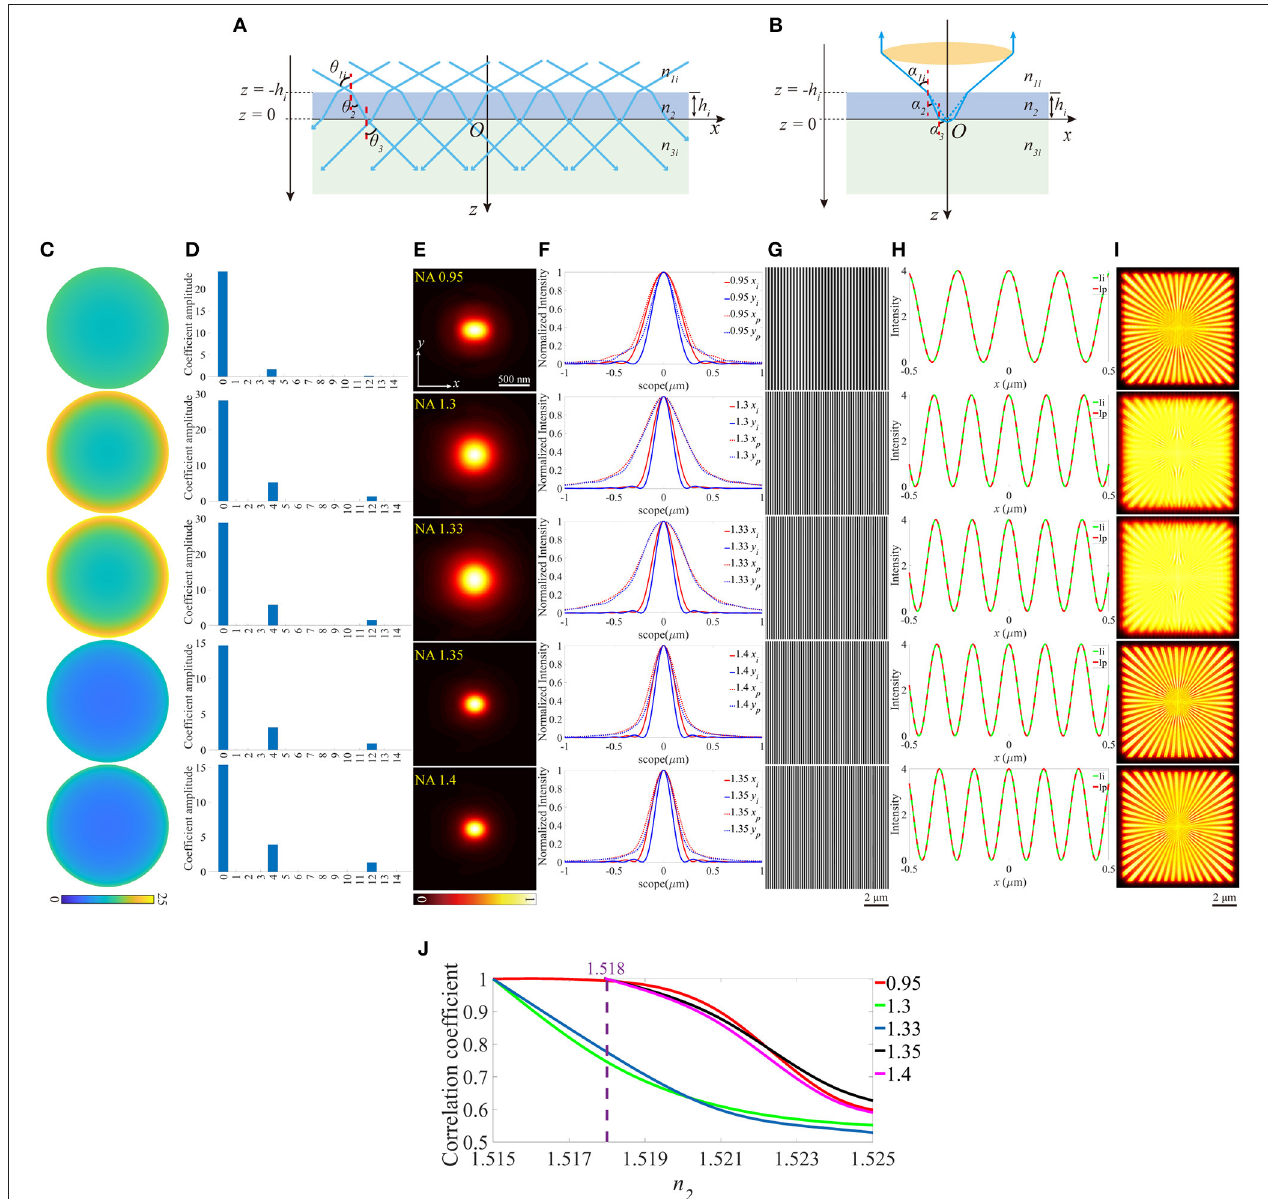
FIGURE 2 | The aberrations induced by the deviation of the RI of the coverslip. (A,B) The RIs between the immersion medium and the coverslip mismatch for the illumination path and the detection path, respectively. (C) The pupil functions calculated from the case depicted in (B) . (D) Zernike decomposition of the pupil functions shown in (C) . (E) The PSFs on the plane z = 0, calculated from the corresponding pupil functions. (F) The profiles of the ideal (solid line) and biased (dashed line) PSFs in (E) . (G) The excitation patterns affected by these biased RIs. (H) The local profiles of the corresponding excitation patterns shown in (G) . The red dashed line Ip presents the biased case and the green solid line Ii presents the ideal case, respectively. The scope is − 0.5 ∼ 0.5 µ m. (I) The corresponding reconstructed images of SIM. (J) The correlation coefficients of SIM images with different n 2 and NAs. The purple dashed line corresponds to n 2 = 1.518.